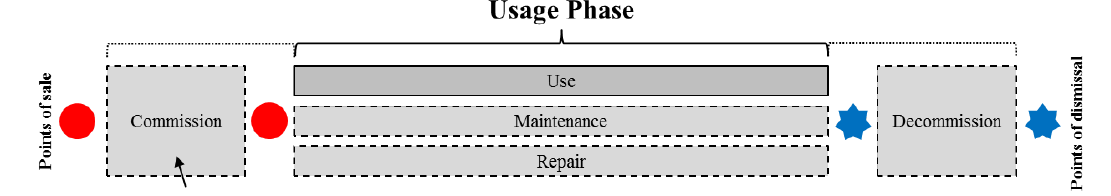
Figure 4. Middle of life phase for durable goods (adapted from [27], see also [26]).